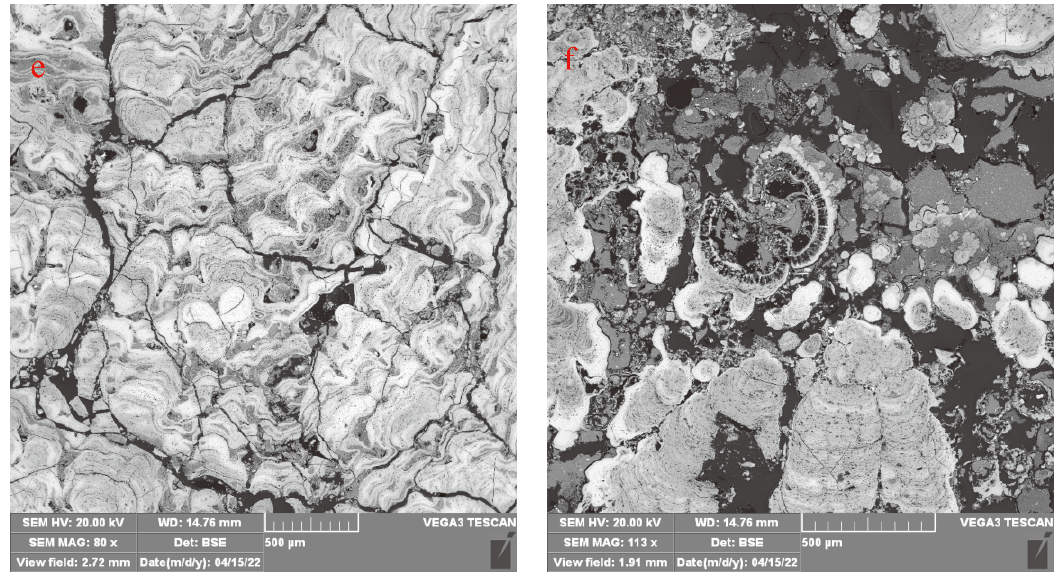
Figure 3. ( a ) Disorderly arranged columns form a shape similar to dendrite; ( b ) banded Si-Fe-rich cements; ( c ) mottled structure composed of siliceous debris and ferromanganese oxides; ( d ) disorderly arranged columns developed into columnar structure; ( e ) laminar structure composed of ferromanganese oxides in Figure 3d; ( f ) foraminifera entered in gaps between columns in Figure 3d, and Mn-Fe rich oxides precipitated around it over time.